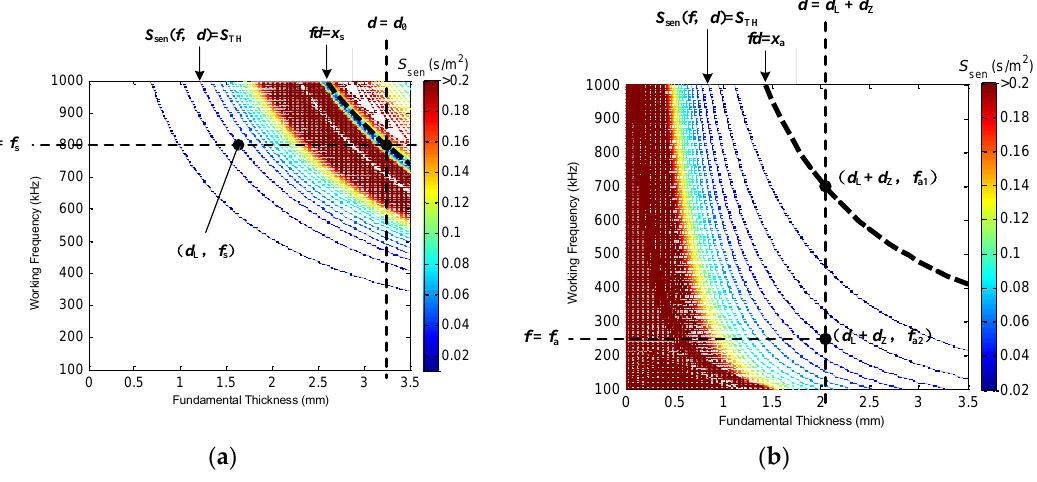
Figure 3. Principles for determining the working parameters. ( a ) S0-mode LW working parameters and ( b ) A0-mode LW working parameters.